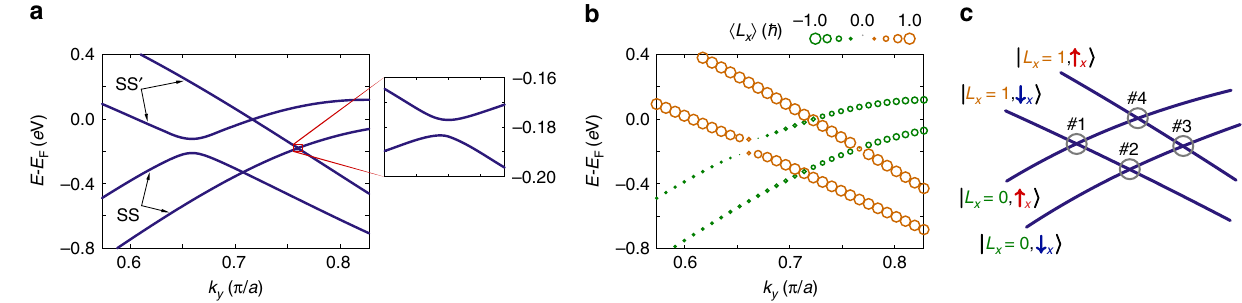
Fig. 3 Orbital angular momentum of the surface states. a The fourfold crossing of the SS and SS 0 surface states in our tight-binding model (see Methods section). A magni fi ed view of crossing #3 is shown inset. b Reproduction of the tight-binding dispersions from a , with the calculated expectation value of the orbital angular momentum along the x quantisation axis shown as symbol colour/size. c Schematic of the fourfold crossing of SS and SS 0 surface states. The crossings are numbered as in Fig. 2 c , and ket labels on the bands represent the orbital and spin angular momenta of the bands in our minimal